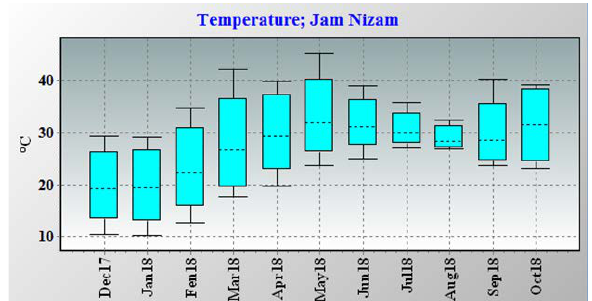
Figure 8. Box plot for the temperature of Jam Nizam